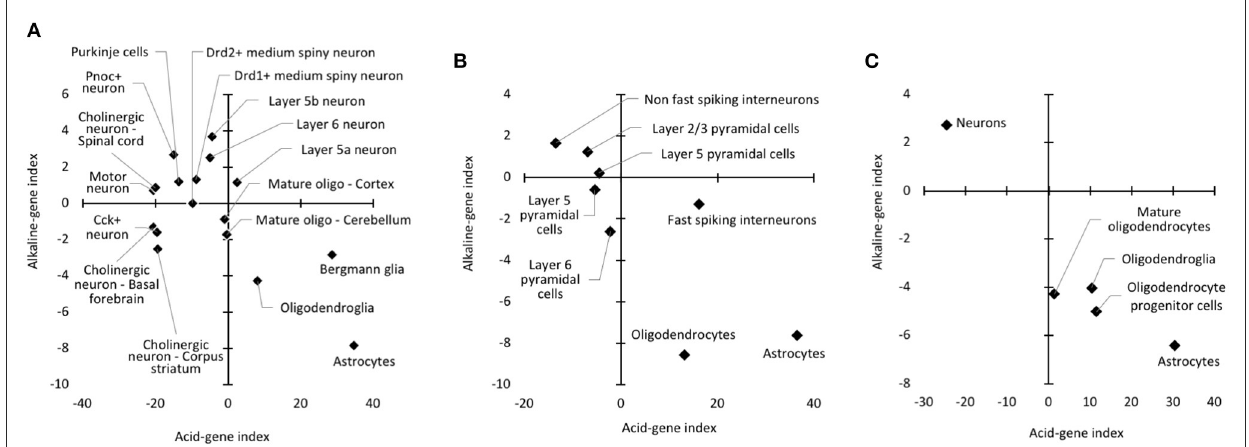
FIGURE5 Cell type differences in acid-gene and alkaline-gene indices. Patterns of acid-gene and alkaline-gene indices for each cell type using datasets from GSE13379 (A) , GSE21997 (B) , and GSE30626 (C) .